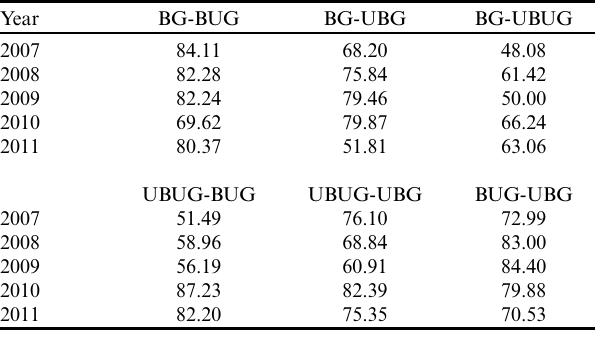
Table 2 . Sørensen’s quantitative indices comparing the songbird community in burned-grazed (BG), burned-ungrazed (BUG), unburned-grazed (UBG), and unburned-ungrazed (UBUG) sites in southern Saskatchewan, 2007 through